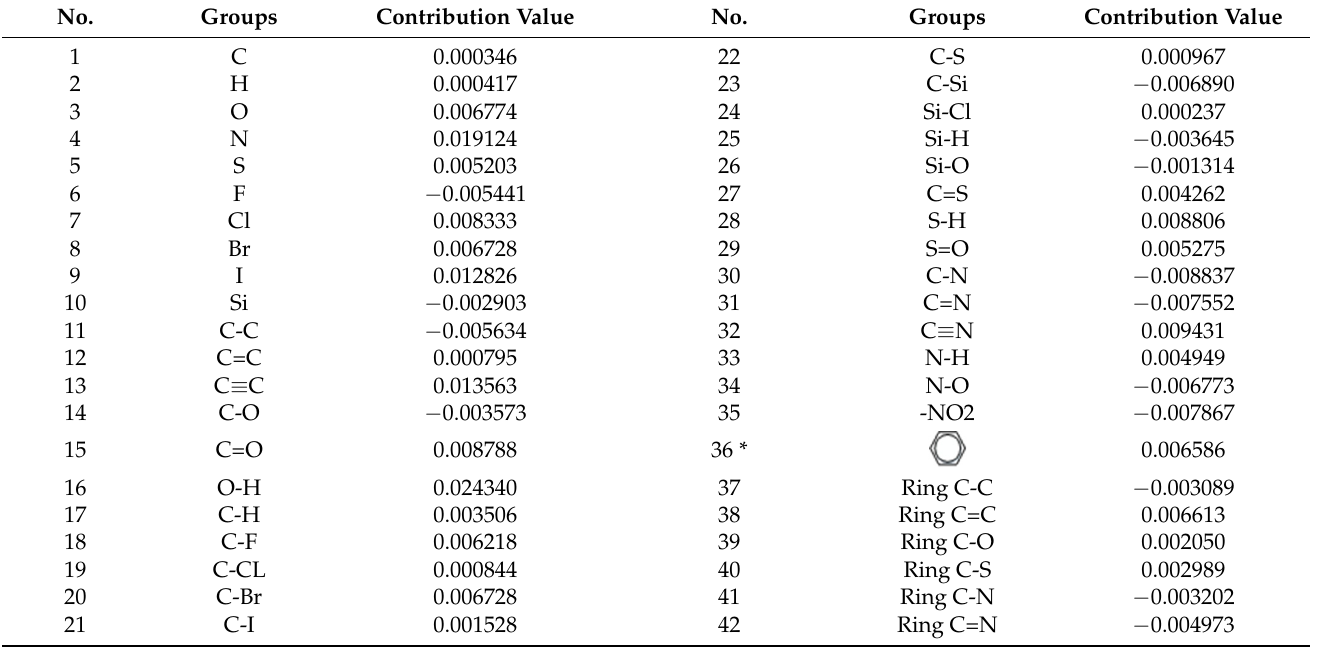
Table 1. Contribution value of elements and chemical bonds to organic compounds obtained by regression.